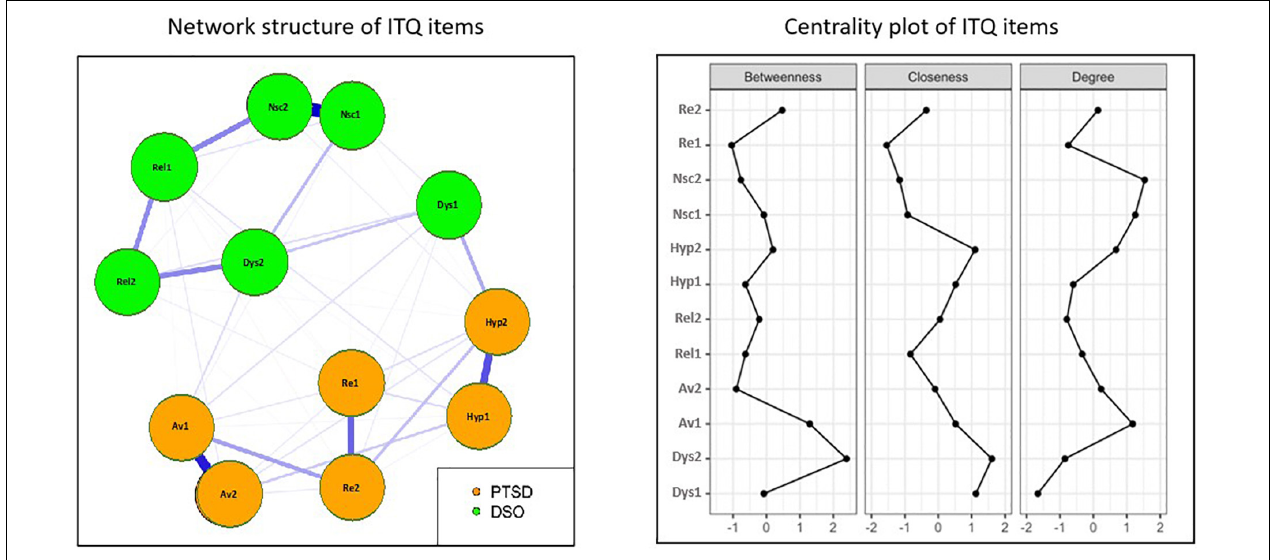
FIGURE 1 | Network structure and centrality measures of ITQ items.